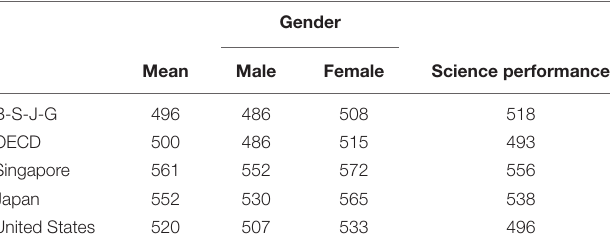
TABLE 3 | The CPS competency of B-S-J-G, OECD, and other countries.